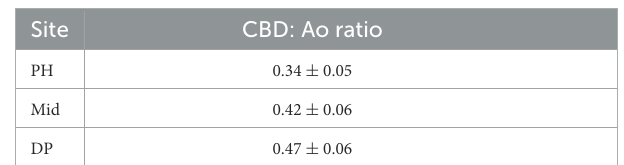
TABLE 2 Values of normal reference range of CBD: Ao ratio at PH, Mid, and DP